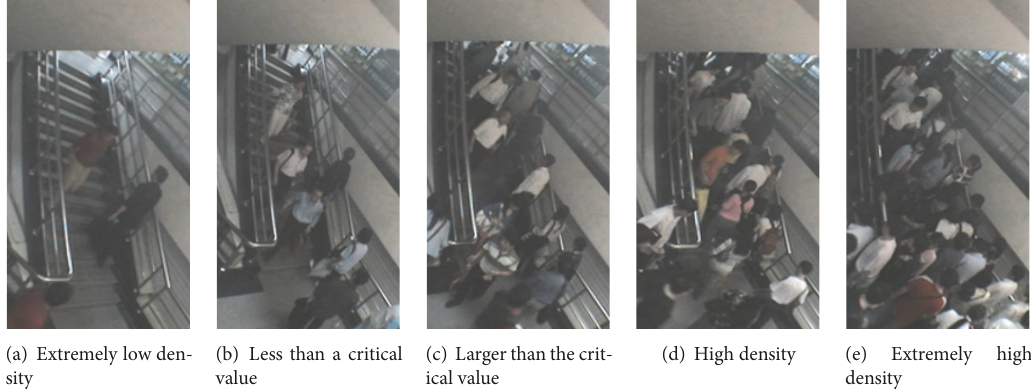
Figure 12: Illustrations of bidirectional stairway pedestrian flow at different density levels.